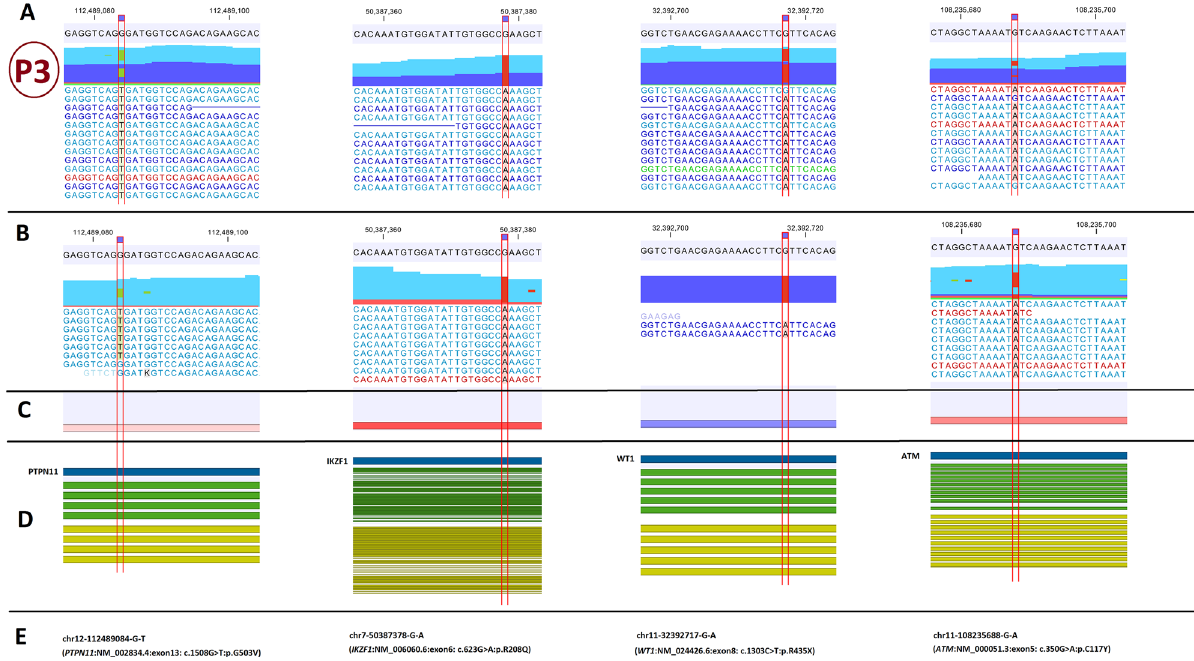
Figure 3. The paired-end mapping read-track displaying reads and detected variants in the third patient. The potentially important findings from WES data analysis is presented in the CLC genomics workbench software. ( A ) hg38 sequence track with WES mapped reads track; ( B ) hg38 sequence track with RNA-Seq mapped reads track; ( C ) Gene expression track; ( D ) gene, mRNA and CDS tracks; ( E ) the variant genomic coordinate on hg38 and the variant name. P3: patient